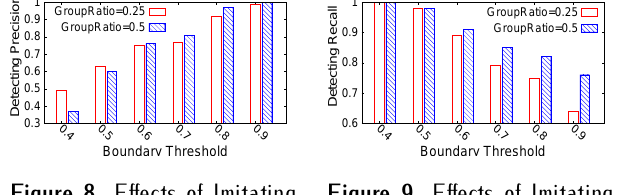
Figure 8. Effects of Imitating Group Ratio on Precision